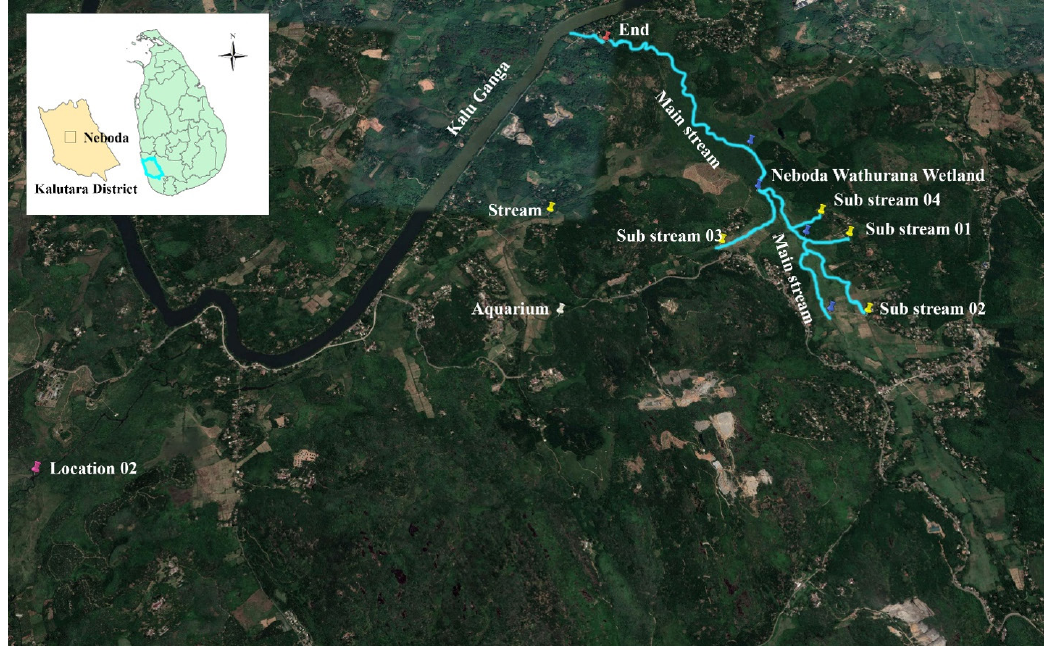
Figure 3: A map depicting the sampling site in the Neboda area in the Kalutara district. The mainstream, that runs through the Naboda Wathurana wetland is marked with blue pins while the sub-streams are marked with yellow pins. Owilana, the second location is marked as location